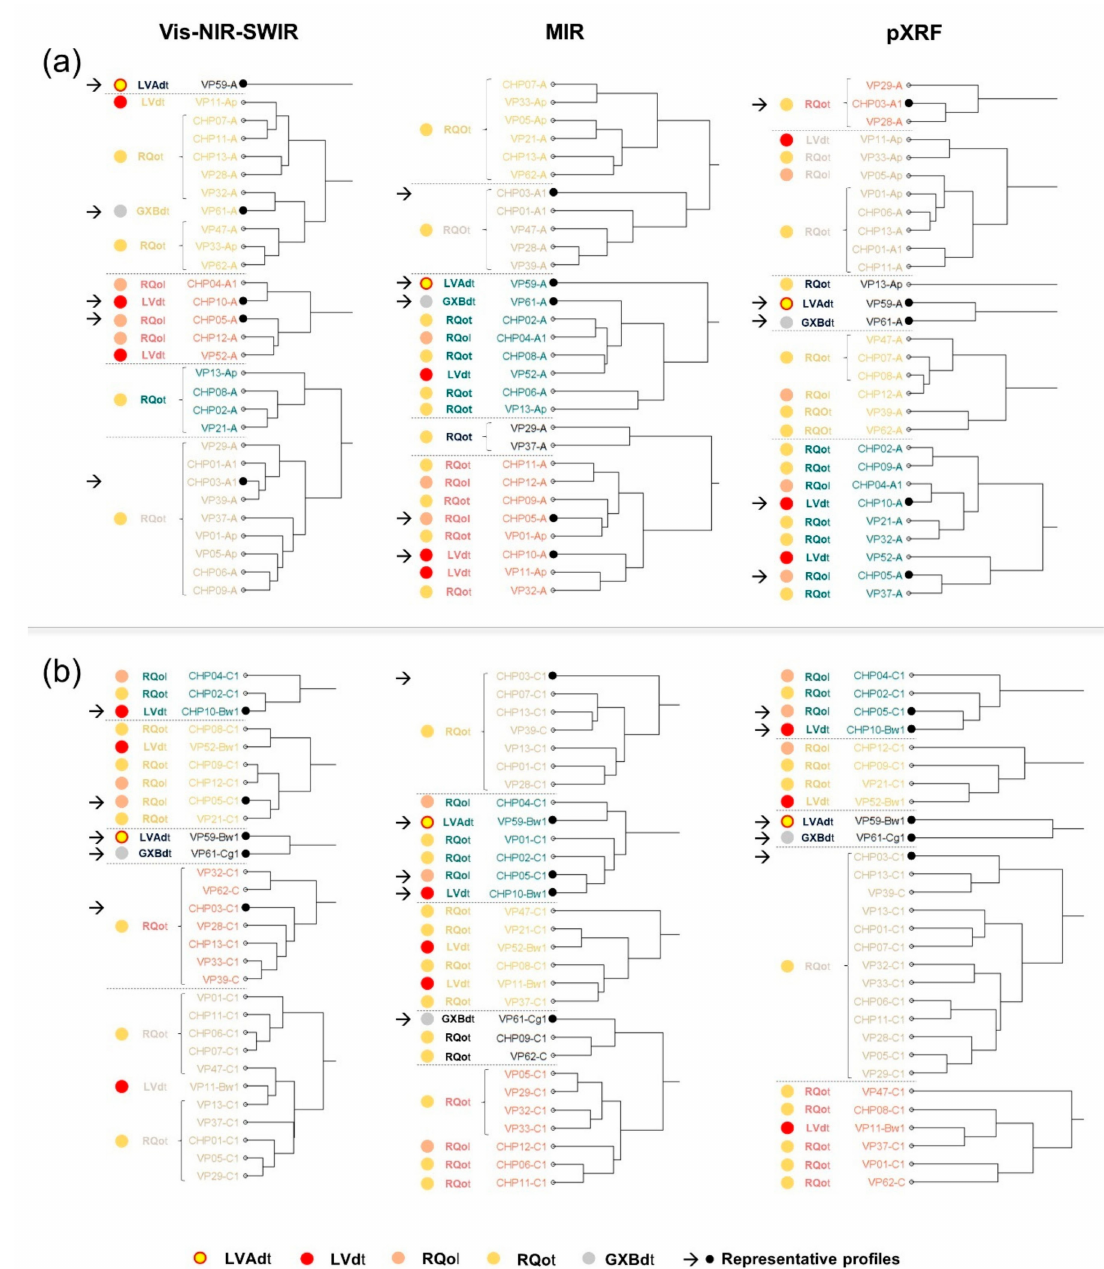
Figure 6. Principal component analysis (PCA) of representative profiles based on the VNS and MIR spectra of the surface ( a ) and subsurface ( b )